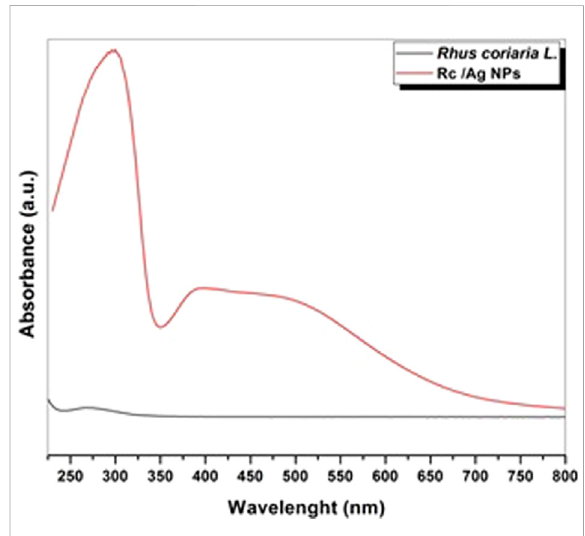
FIGURE 2 UV-Vis Spectrum of Ag nanoparticles obtained by sumac- mediated green synthesis.